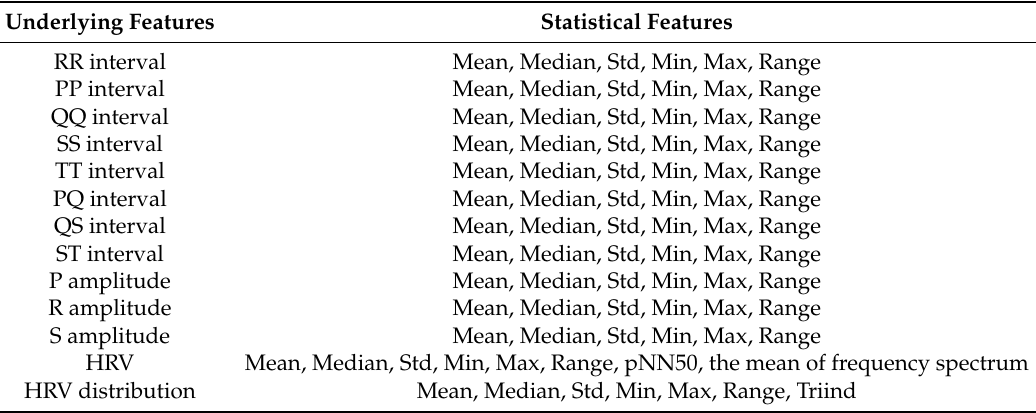
Table 1. Features extracted from ECG